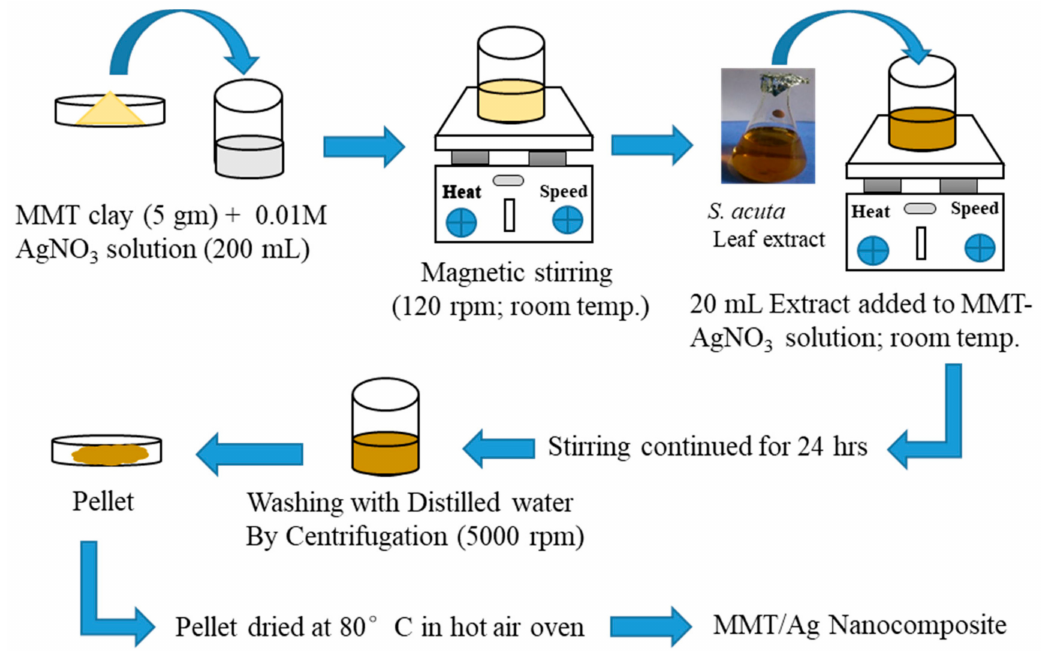
Figure 3. Synthesis process of MMT/Ag